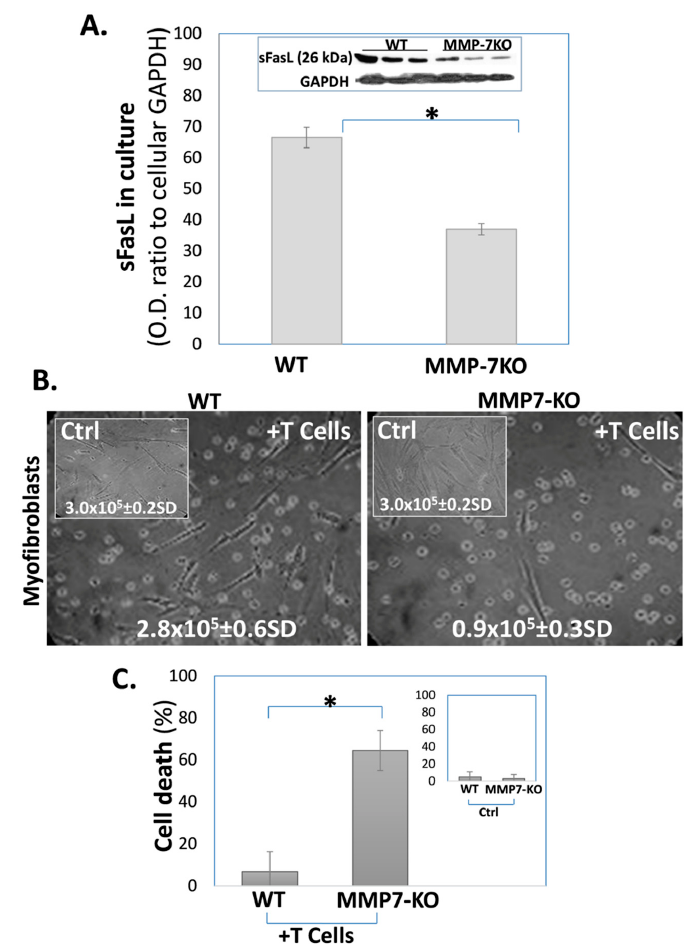
Figure 4. The decreased levels of sFasL in the culture medium of MMP-7 KO lung myofibroblasts increase their susceptibility to cell death when further co-cultured with T cells. ( A ) Western blot of sFasL in culture medium, of lung fibroblasts (3 × 10 5 ), isolated from bleomycin-treated lungs (day 14) of WT vs. MMP-7 KO mice; Graphical presentation and blots (insert) with optical density ratios normalized to fibroblasts’ GAPDH. Mean ± standard deviation; n = 3; * p < 0.05. ( B ) Light microscope images with trypan blue exclusion (inserted numbers); and ( C ) Graphical presentation of the cell death percentage defined by trypan blue exclusion. Comparisons were made between myofibroblasts from lungs of bleomycin-treated wild type (WT) vs. MMP7 knockout (MMP-7 KO) cultured alone (inserts-Ctrl) and co-cultured with T cells (1 × 10 6 , 48 h), (WT or MMP7-KO, + T cells). Mean ± standard deviation; n = 3; * p <